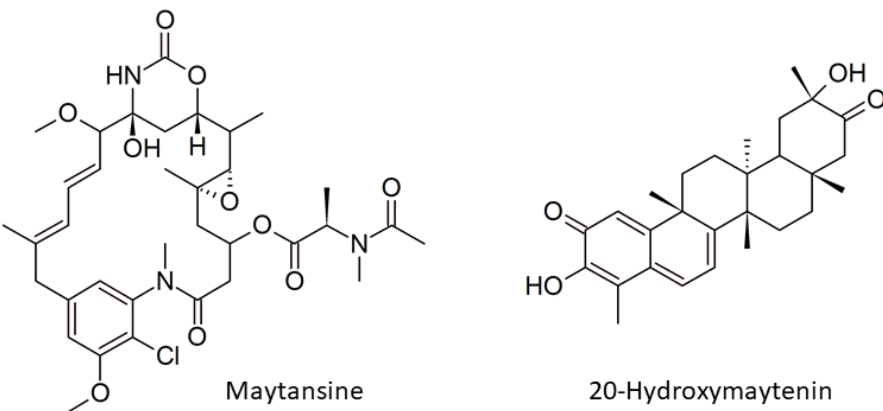
Figure 1. Chemical structure of maytansine ( left ) and 20-hydroxymaytenin ( right ).